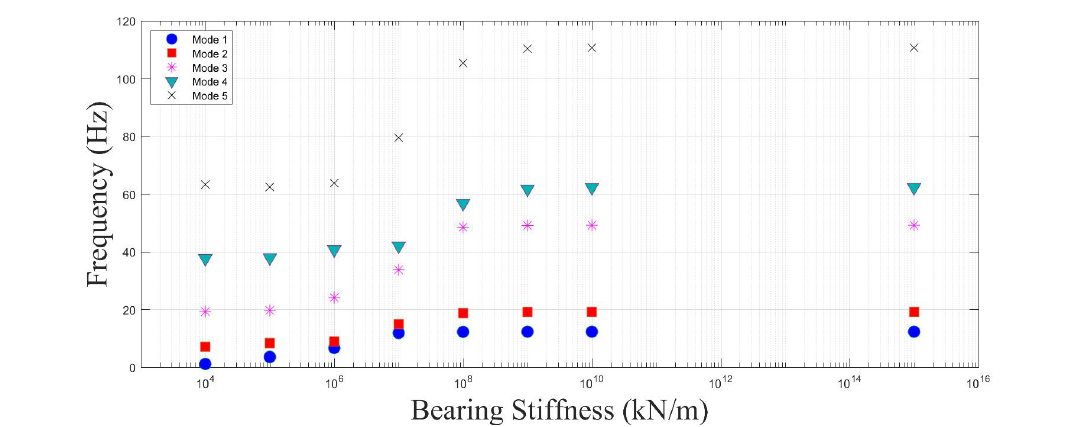
Figure 11. Variation of the eigenvalues of the two span bridge with bearing